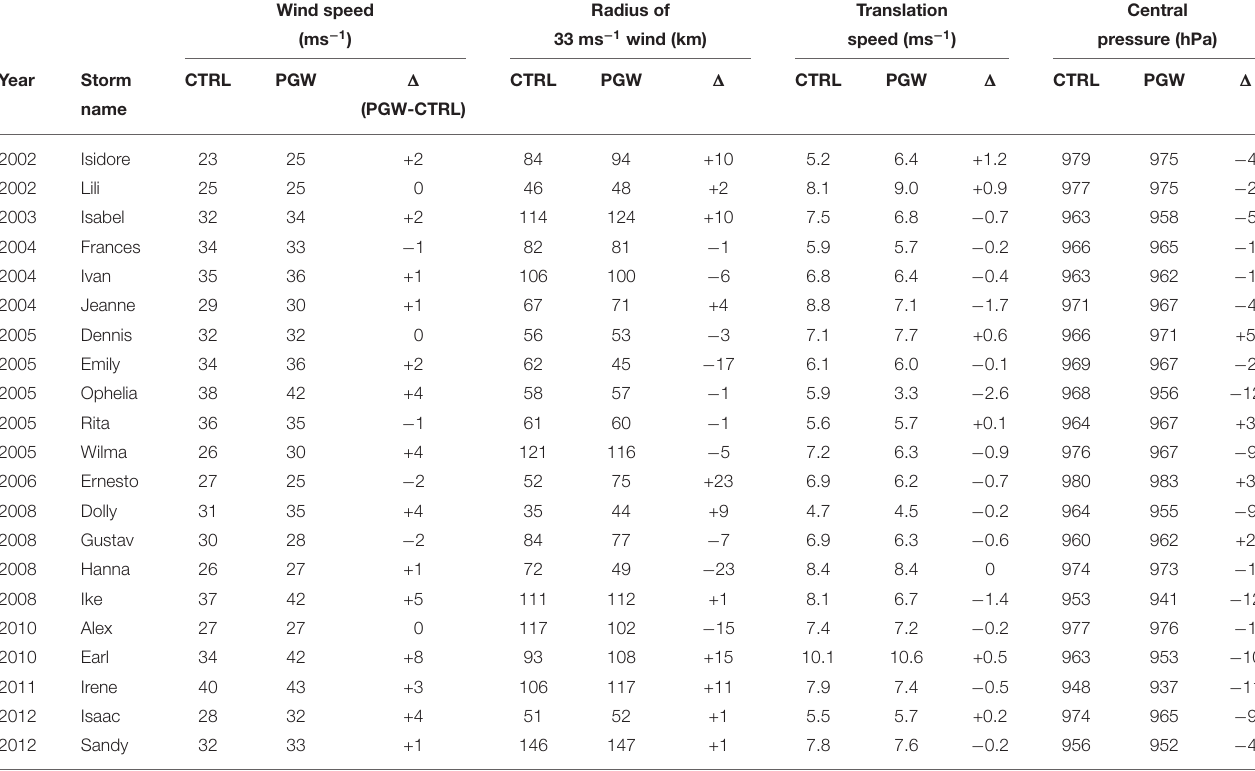
TABLE 3 | Summary of average hurricane characteristics of each simulated